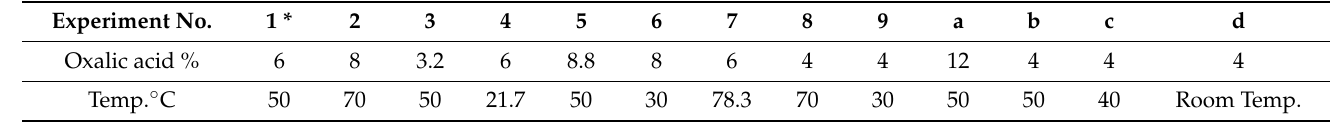
Table 1. The actual levels of the operating variable for acidizing